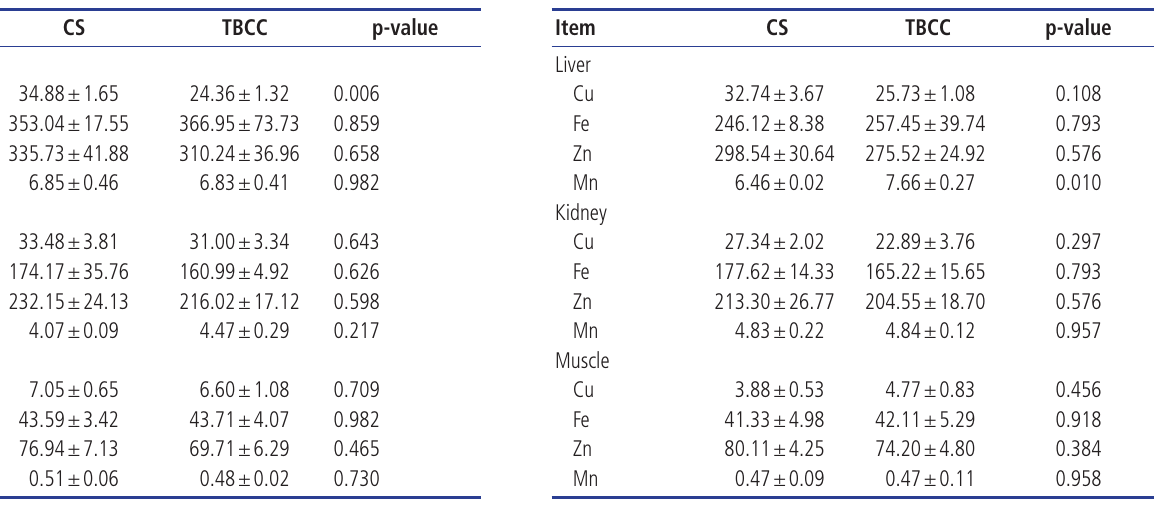
Table 5. Effect of copper sulfate (CS) and tribasic copper chloride (TBCC) on the concentrations of Cu, Fe, Zn, and Mn in tissues on d 102 (mg/kg dry